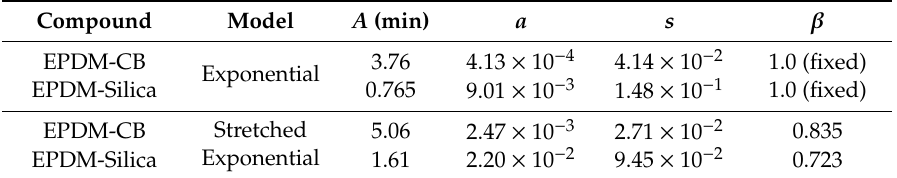
Table 3. Fictive strain model parameters.